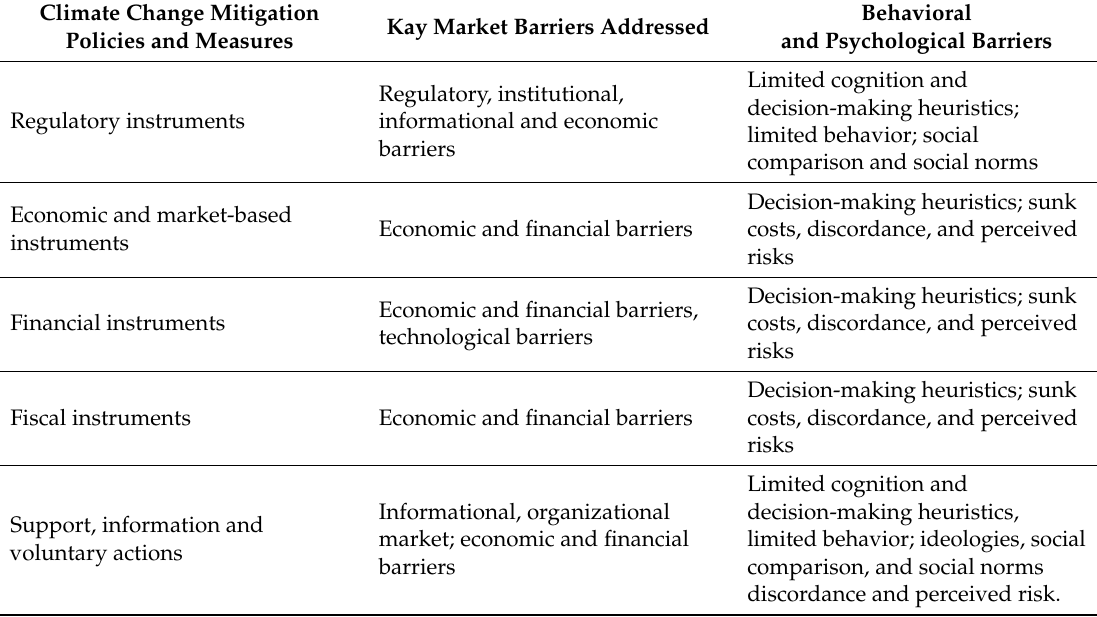
Table 6. The relationship between unsuccessful climate change mitigation measures to overcome market failures and behavioral and psychological